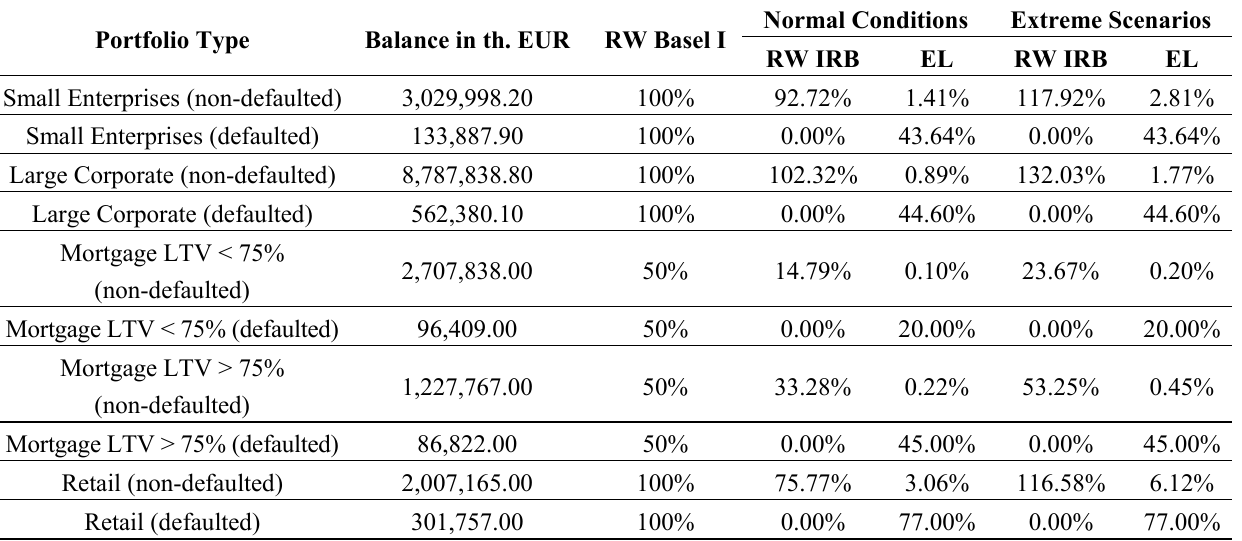
Table 6. Bank 3: RW analysis per portfolio for normal and extreme scenarios.